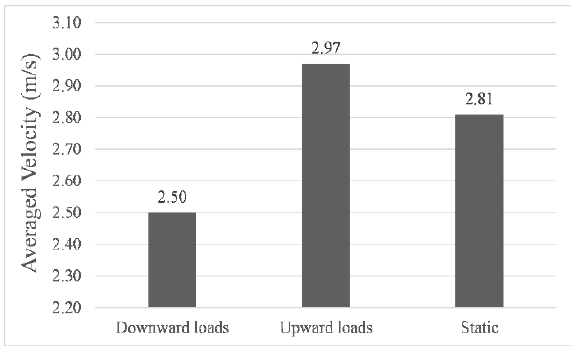
Figure 8. Averaged velocity of simulated navigations.